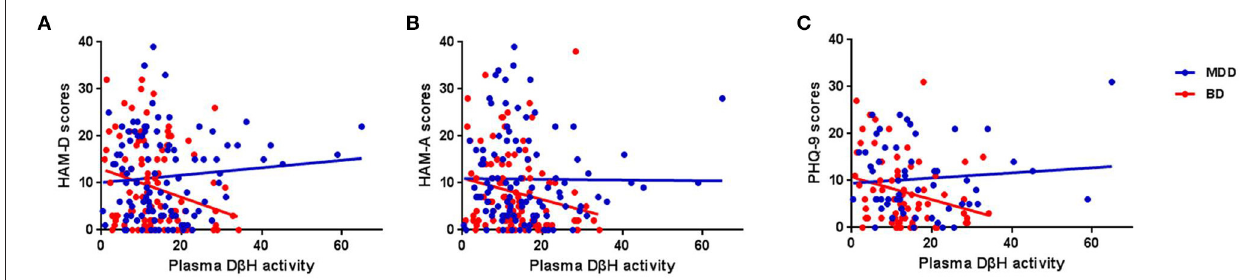
FIGURE 3 | Associations between plasma D β H activity and clinical assessments in MDD and BD patients. (A–C) Showed the associations between plasma D β H activity and Hamilton Depression Scale (HAM-D) scores, Hamilton Anxiety Scale (HAM-A) scores, and Patient Health Questionnaire-9 (PHQ-9) scores, respectively. Significant negative correlations were found between D β H activities and HAM-D scores ( r = − 0.234, p = 0.021), or HAM-A scores ( r = − 0.201, p = 0.041) in BD patients. However, no significant correlation was found between plasma D β H activity and clinical assessments in MDD patients (all p >